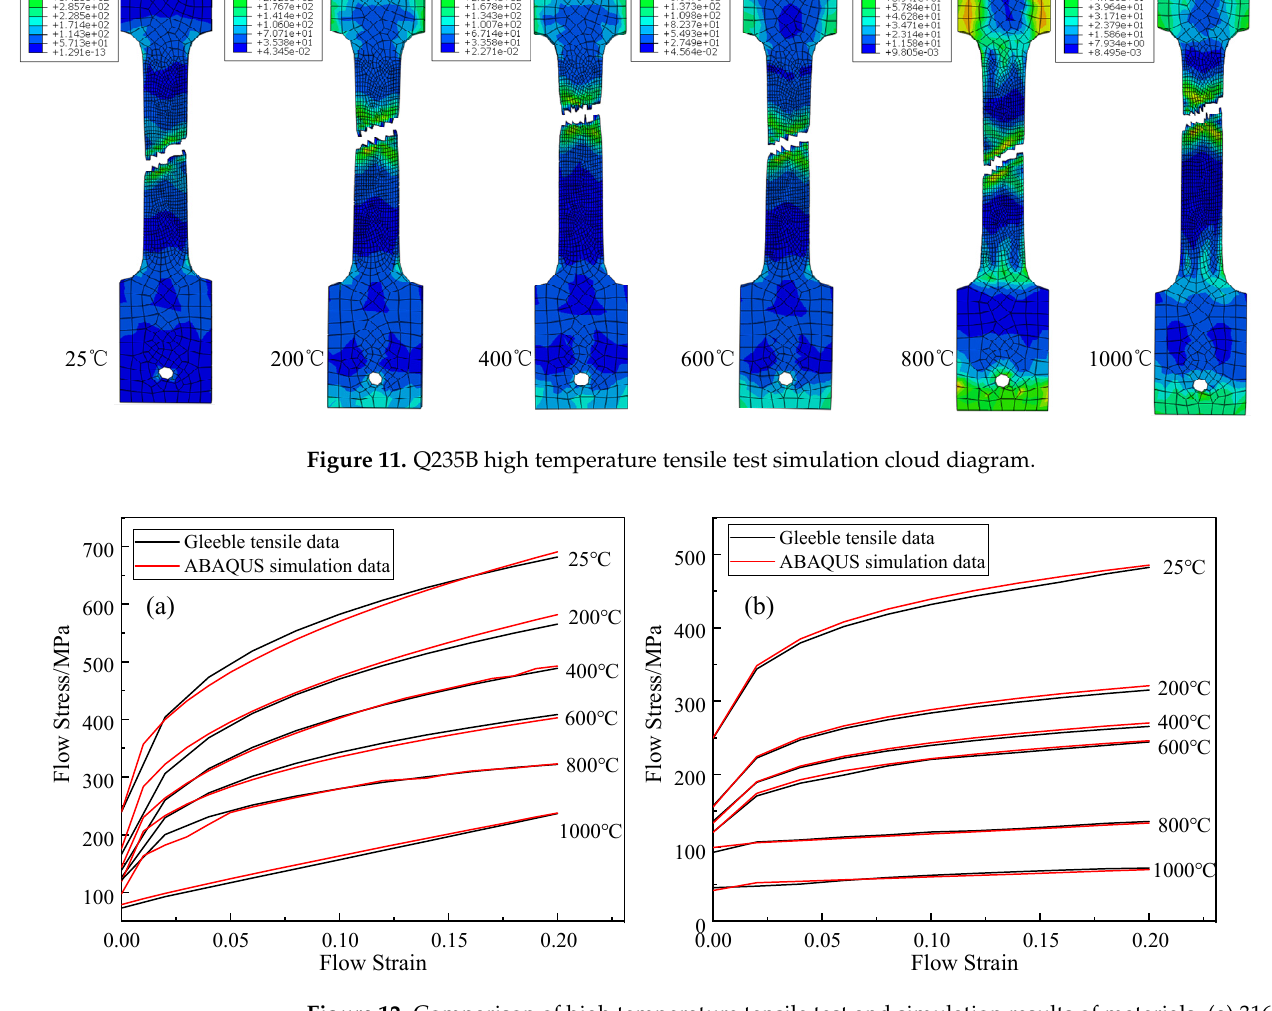
Figure 12. Comparison of high temperature tensile test and simulation results of materials. ( a ) 316L; ( b ) Q235B.